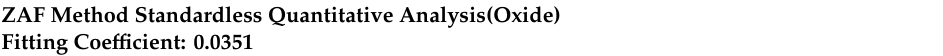
Table 9. The Oxide of resin reinforced Coco-husk ( Cococs nucifera ).